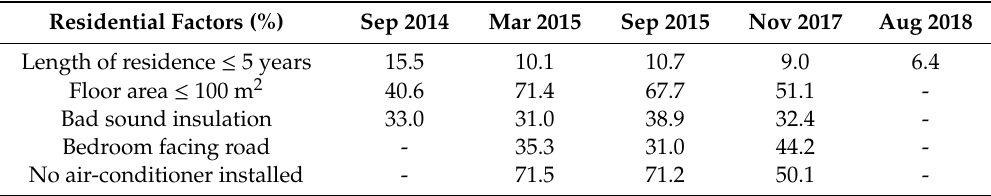
Table 6. Changes in residential factor through the surveys from 2014 to 2018.